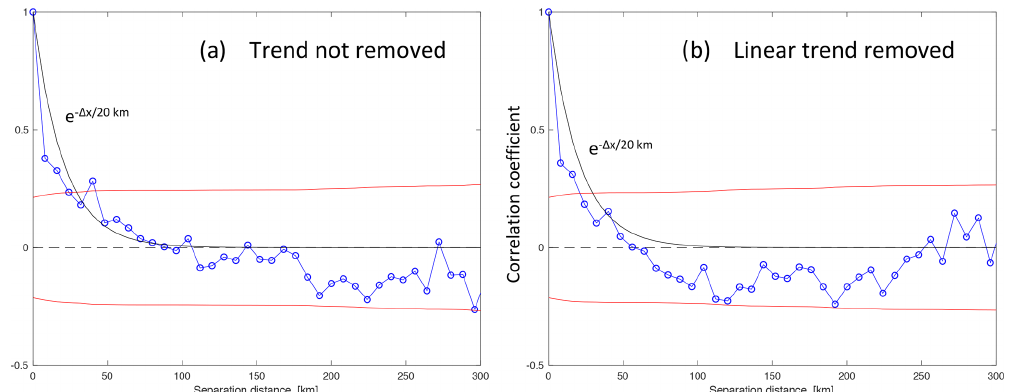
Figure 1. The autocorrelation of the MFLL–OCO-2 difference computed across six ACT-America flight legs as a function of the sepa- ration distance (cid:49)x [km] along the OCO-2 ground track (blue), plus its 1 σ significance bounds (red). Plots are given for two different pre-conditioning methods: (a) subtracting off only a constant offset or (b) subtracting off a linear trend from each flight leg. An exponentially decaying curve with a correlation length of 20km is also plotted in both